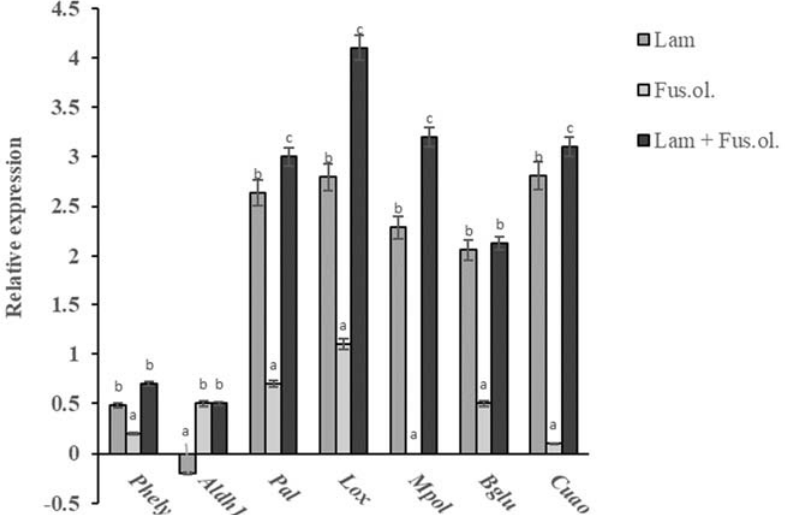
Figure 4. Expression of defense-related genes in olive plants treated with laminarin (Lam), artificially inoculated with Fusicladium oleagineum (Fus. ol.), treated with laminarin and artificially inoculated plants with F. oleagineum (Lam + Fus. ol.). Transcription levels were determined by real-time quantitative PCR (RT-qPCR) 1 day after inoculation with F. oleagineum or 3 days after laminarin application. Results were expressed as the fold increase in transcript levels and normalized to mock-inoculated plants. The actin gene was used as endogenous control. Values represent the mean of triplicates of the experiment. Different letters on the columns indicate significant differences inside each gene studied for the three different treatments according to analysis of variance (ANOVA) at p = 0.05.